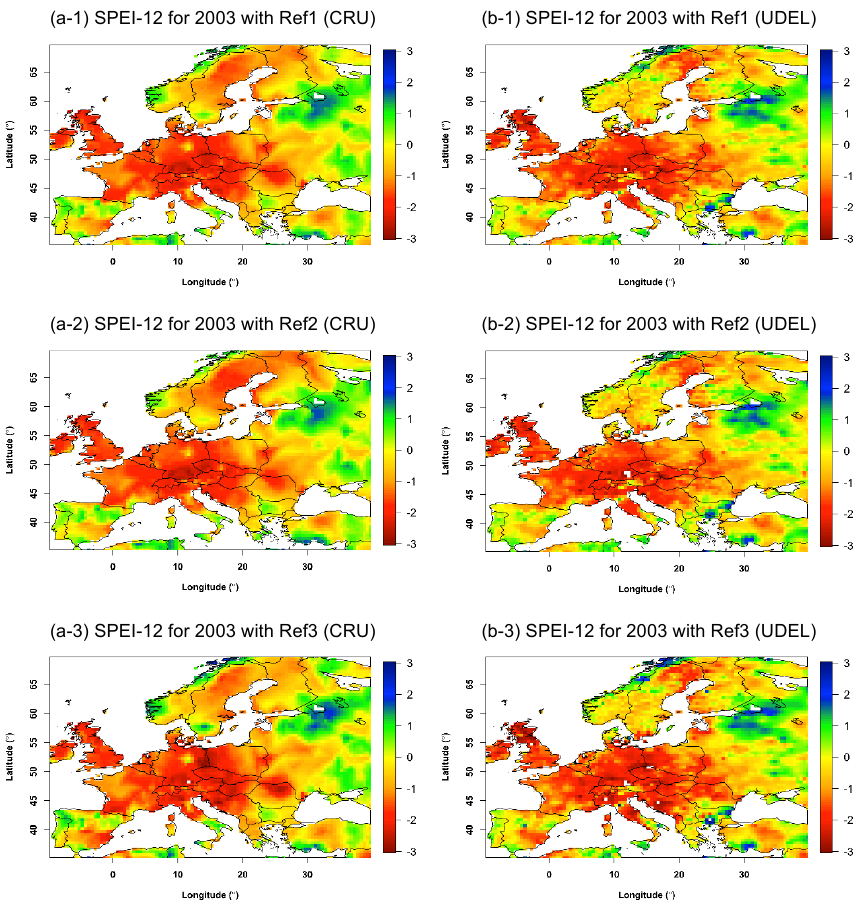
Figure 14. Spatial distribution of SPEI-12 for three different reference periods (Ref1, Ref2 and Ref3 in Table 2) based on the (a) CRU and (b) UDEL datasets in Europe in 2003 as an